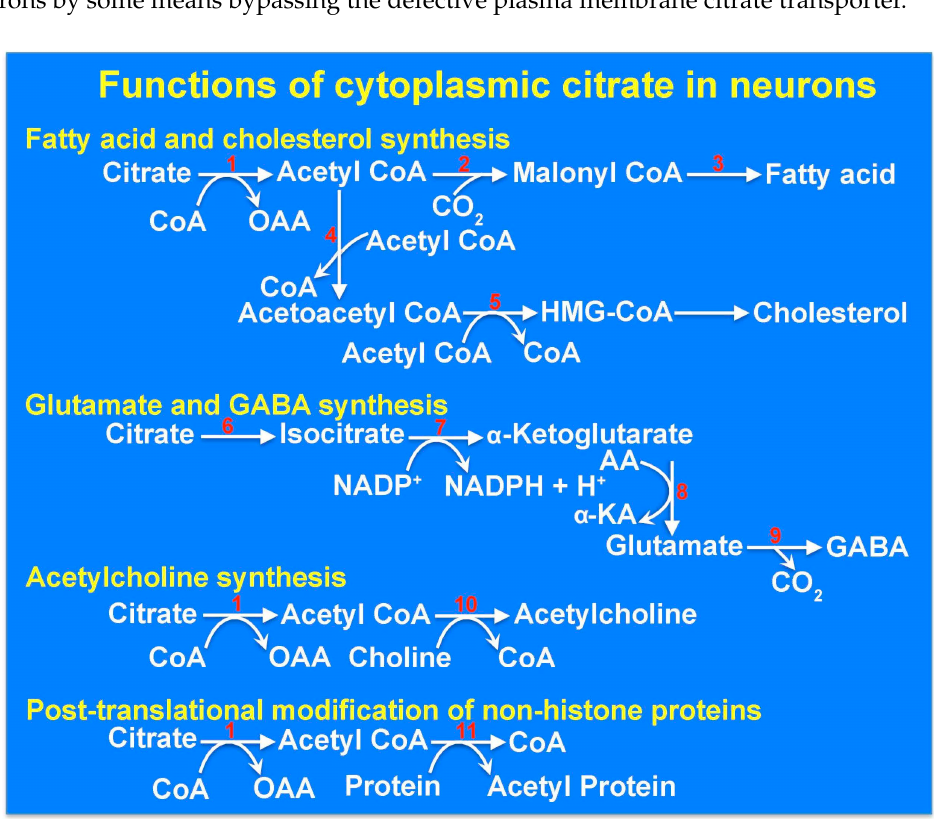
Figure 2. Functions of citrate in the cytoplasm of neurons. The enzymes listed are: 1: ATP:citrate lyase;